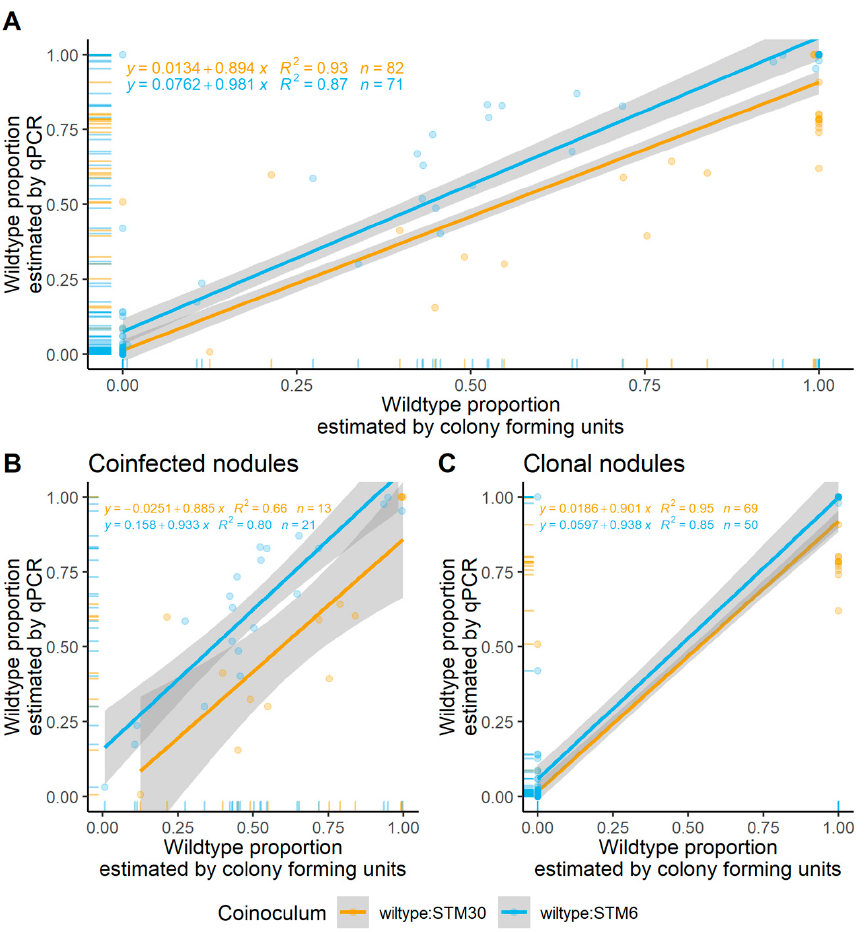
Figure 1. Colony forming units vs. quantitative polymerase chain reaction in planta. The proportion of the wild-type strain was estimated in planta. Wild type was distinguished from the Tn5 mutant using DsRed. DsRed expression is visible under natural light when counting CFUs and provides a specific target for qPCR. Tn5 mutants were identified with qPCR using specific primers targeting the Tn5 transposon and flanking gene region. Linear models are provided for all nodules ( A ), coinfected nodules detected by CFU ( B ), and clonally infected nodules estimated by CFU ( C ) with 95% confidence intervals included (grey) for each set of samples. Each data point represents a proportion estimated for a single nodule. The size of the data point indicates the estimated viable population size by CFU. Marginal plots indicate the number of data points along each axis. Orange = wild type:STM30 samples, and blue = wild type:STM6